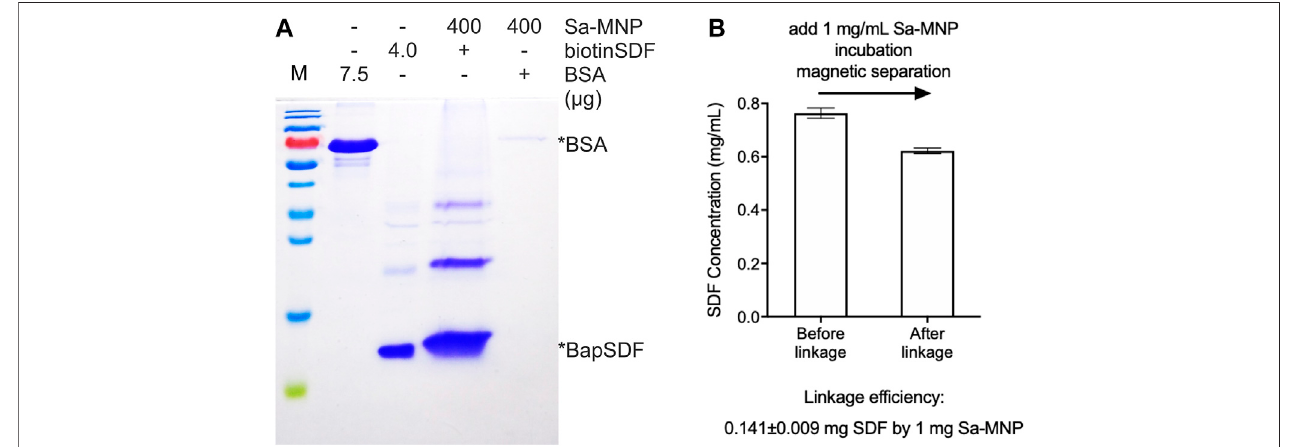
FIGURE 2 | Assembly of SDF-MNP. (A) Estimation of loaded protein using Sa-MNP. BSA and puri fi ed BapSDF co-expressed with BirA were adjusted to 0.5 mg/ ml, and then, Sa-MNP wereadded ata fi nalconcentration of1 mg/ml. Aftersonication and incubation, assembled MNPwereseparated using magnetic separationand washedwithproteinstoragebuffer.Subsequently,400 μ gofassembledMNPweredetected. (B) ELISAestimationofSDFconcentrationbeforeandaftercapturebySa- MNP. The maximum concentration of puri fi ed BapSDF (BirA) collected and used in the incubation mixture. Sa-MNP speci fi cally captured BapSDF (BirA) with an ef fi ciency of approximately 14% in two